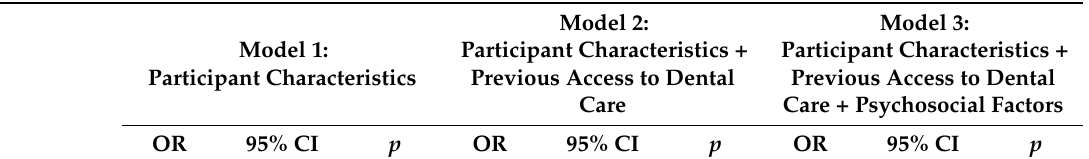
Table 4. Predictors of Participants’ Higher Intention to Serve the Underserved and Vulnerable